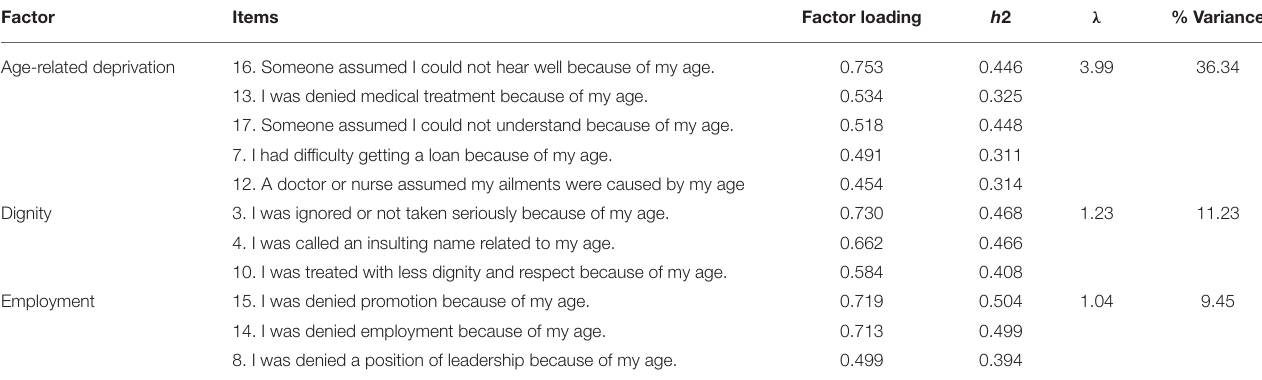
TABLE 2 | The result of EFA on the three factors Iranian version of Ageism Survey (N = 200). Factor